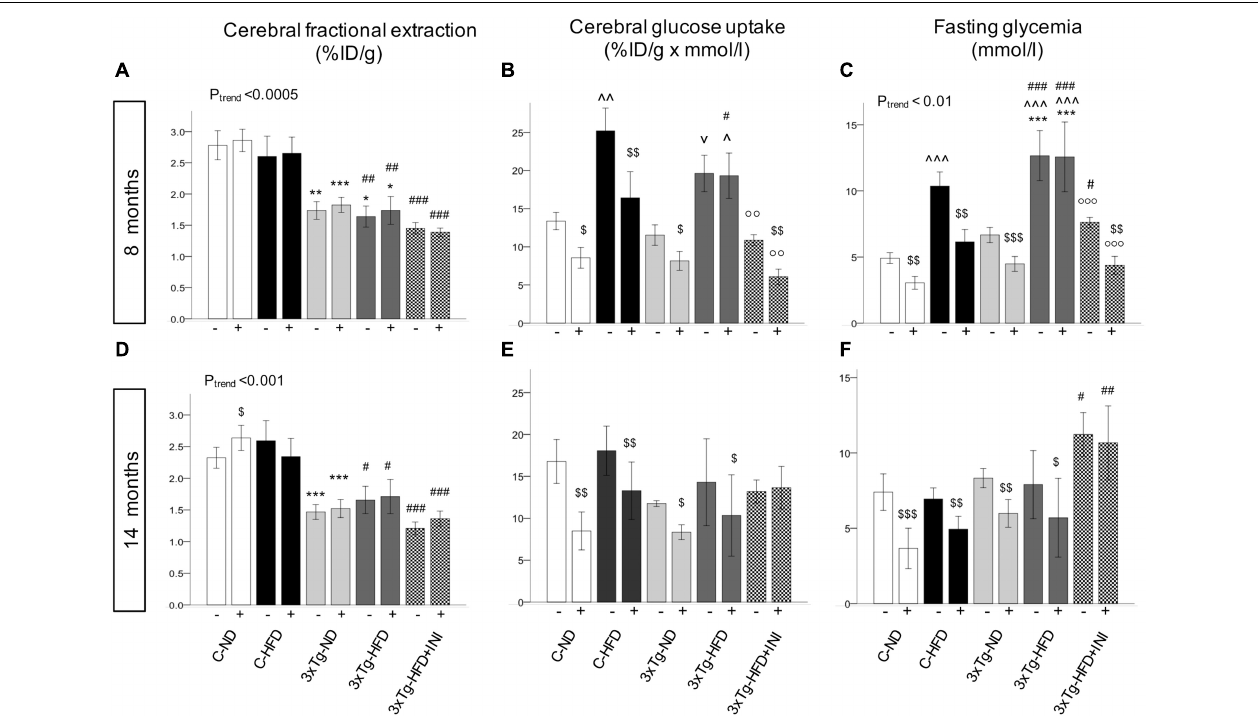
FIGURE 6 | Brain glucose metabolism in 8 (top) and 14 (bottom) months old mice. Fractional extraction (A,D) reflects the intrinsic ability of the brain to actively extract glucose from the circulation, and glucose uptake (B,E) takes into account the mass effect of circulating glucose, and was computed as product of fractional extraction (A,D) and glycaemia during imaging (C,F) . Data are presented as mean ± SEM. Sample sizes are given in Table 1 . P trend refers to regression analyses across the first four groups. ∗ p < 0.05 or less ( ∗∗ , ∗∗∗ ) ND-ND and HFD-HFD (between strains), ∧ p < 0.05 or v p = 0.064 HFD vs. ND (within-strain), # p < 0.05 or less